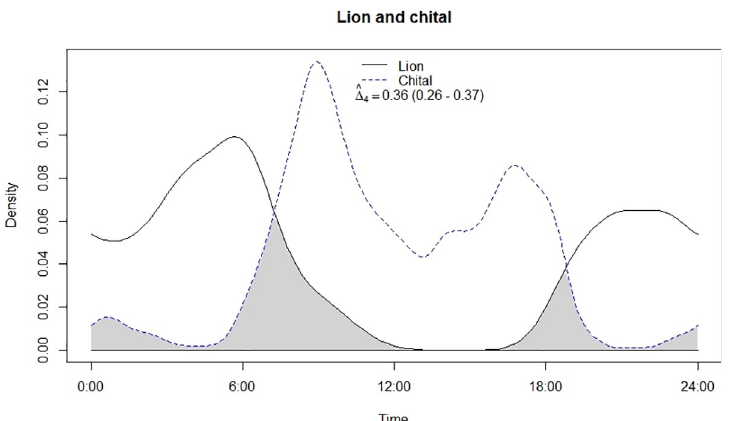
Fig 10. Temporal overlap between lion and